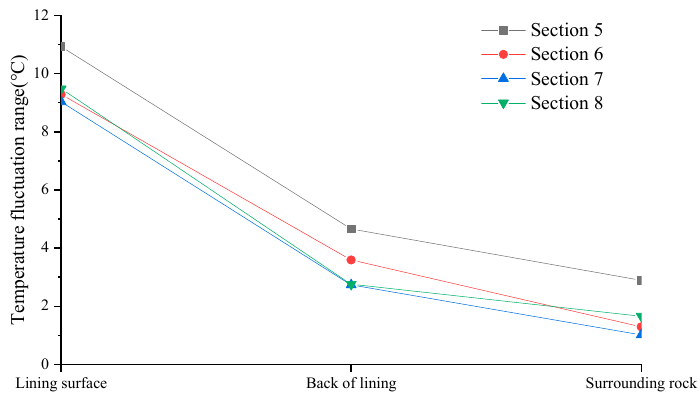
Figure 13. Temperature